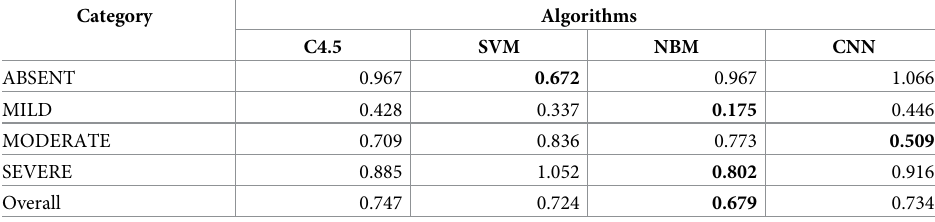
Table 2. A Comparison of the classification performance of popular text classification algorithms and a basic CNN model on the pre-processed training set. The Best Score of Each Category is Highlighted in Bold.